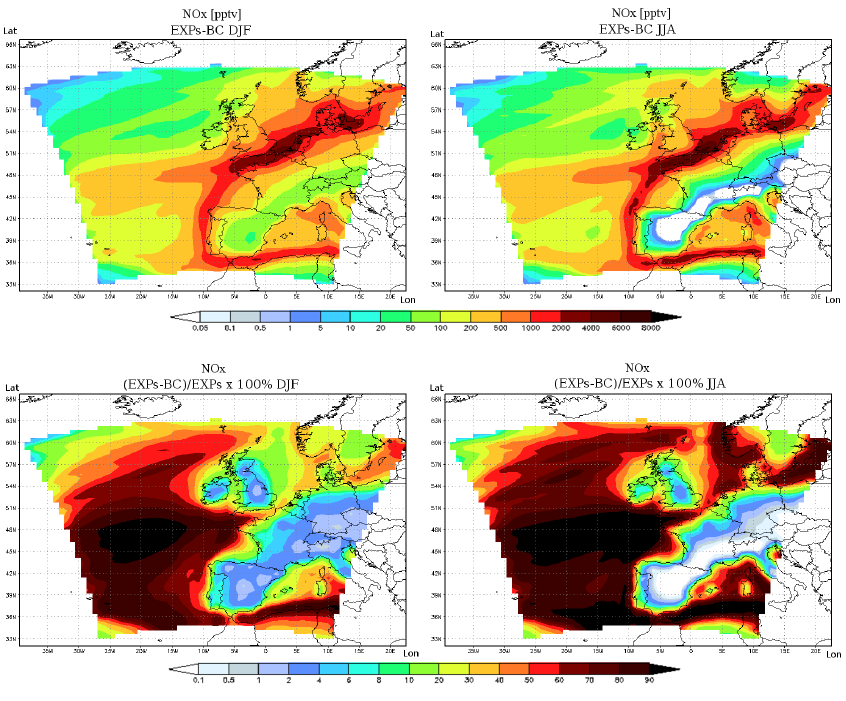
Fig. 2. The top row shows the average absolute NO x change on surface in pptv introducing ship emissions for winter (left) and summer season (right) as difference of experiments EXPs and BC. On the bottom, the relative contribution of ship NO x to the total NO x as (EXPs- BC)/EXPs × 100% is